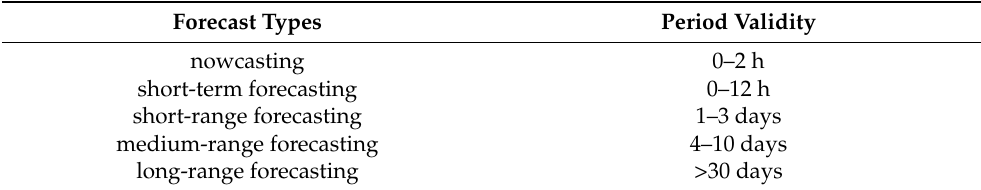
Table 1. Types of weather